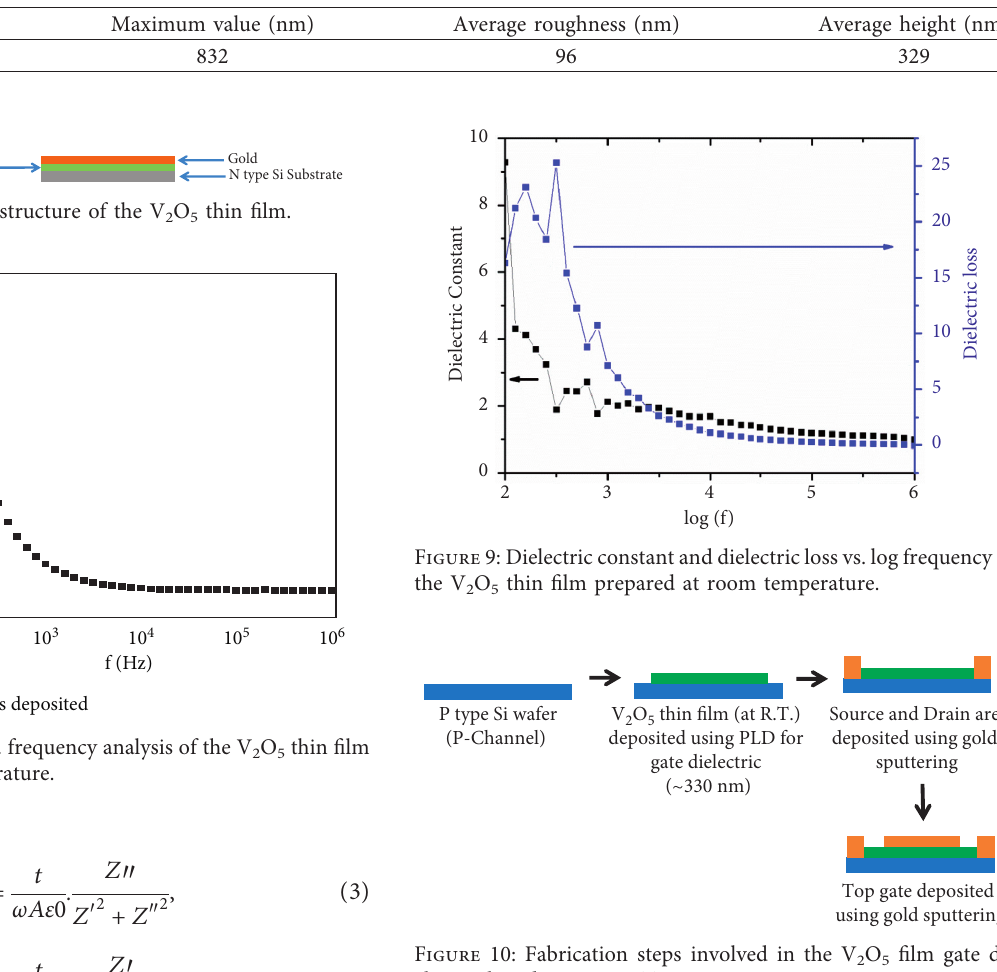
Figure 6: Histogram graph of the AFM image of V Table 2: V 2 O 5 parameter analysis using AFM.